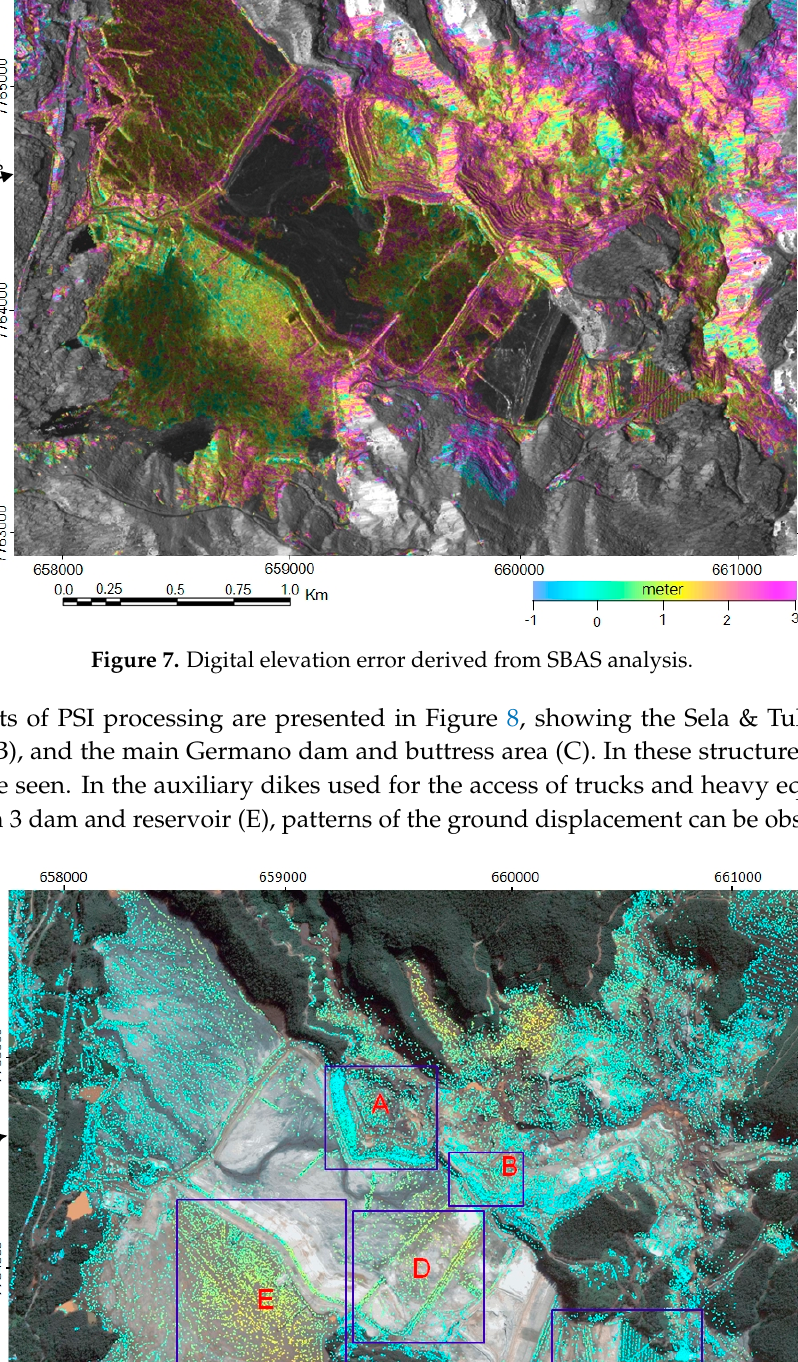
Figure 6. Displacement velocity map in LoS derived from SBAS analysis.